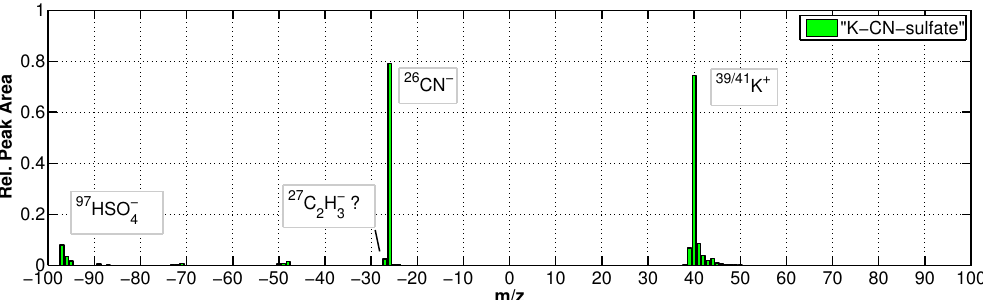
Figure 8. Mass spectra of particle type 3, K-CN-sulfate . This particle type represents a possible candidate for an ocean-derived, biological aerosol. Note that due to a software feature the peak at m/z + 40 actually belongs to 39 K + (please refer to the text for a more detailed explanation).